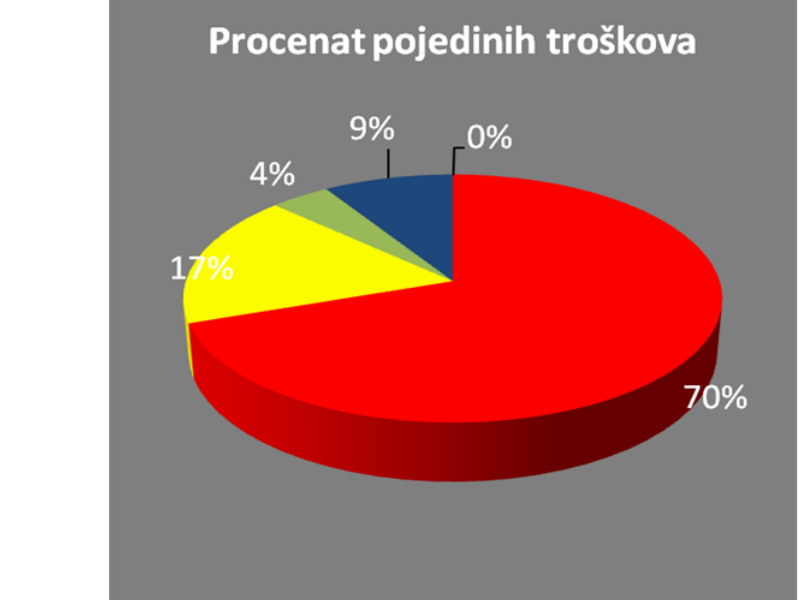
Figure 6 – Percentage of cost categories in overall asset costs during the life cycle, with 50% increased reliabillity of the asset module and 30% decreased number of logistic